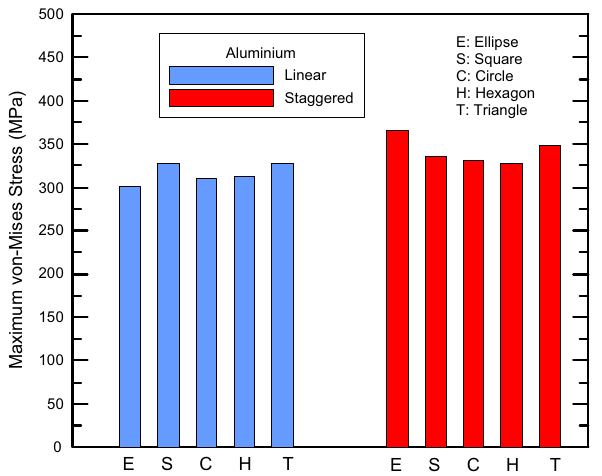
Figure 8: Maximum stress distribution depending on hole geometry in the linear and staggered arrangement of the aluminium perfo - rated